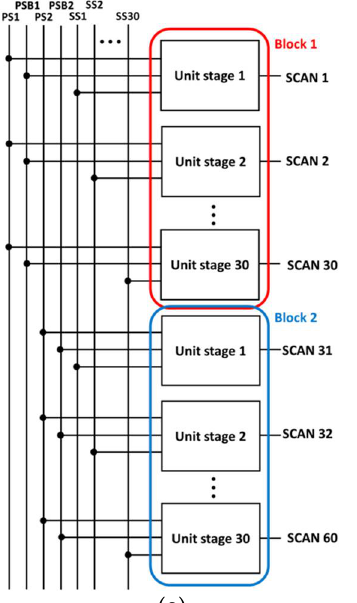
Figure 2. Block diagram of the proposed scan driver ( a ) and its timing chart ( b ).